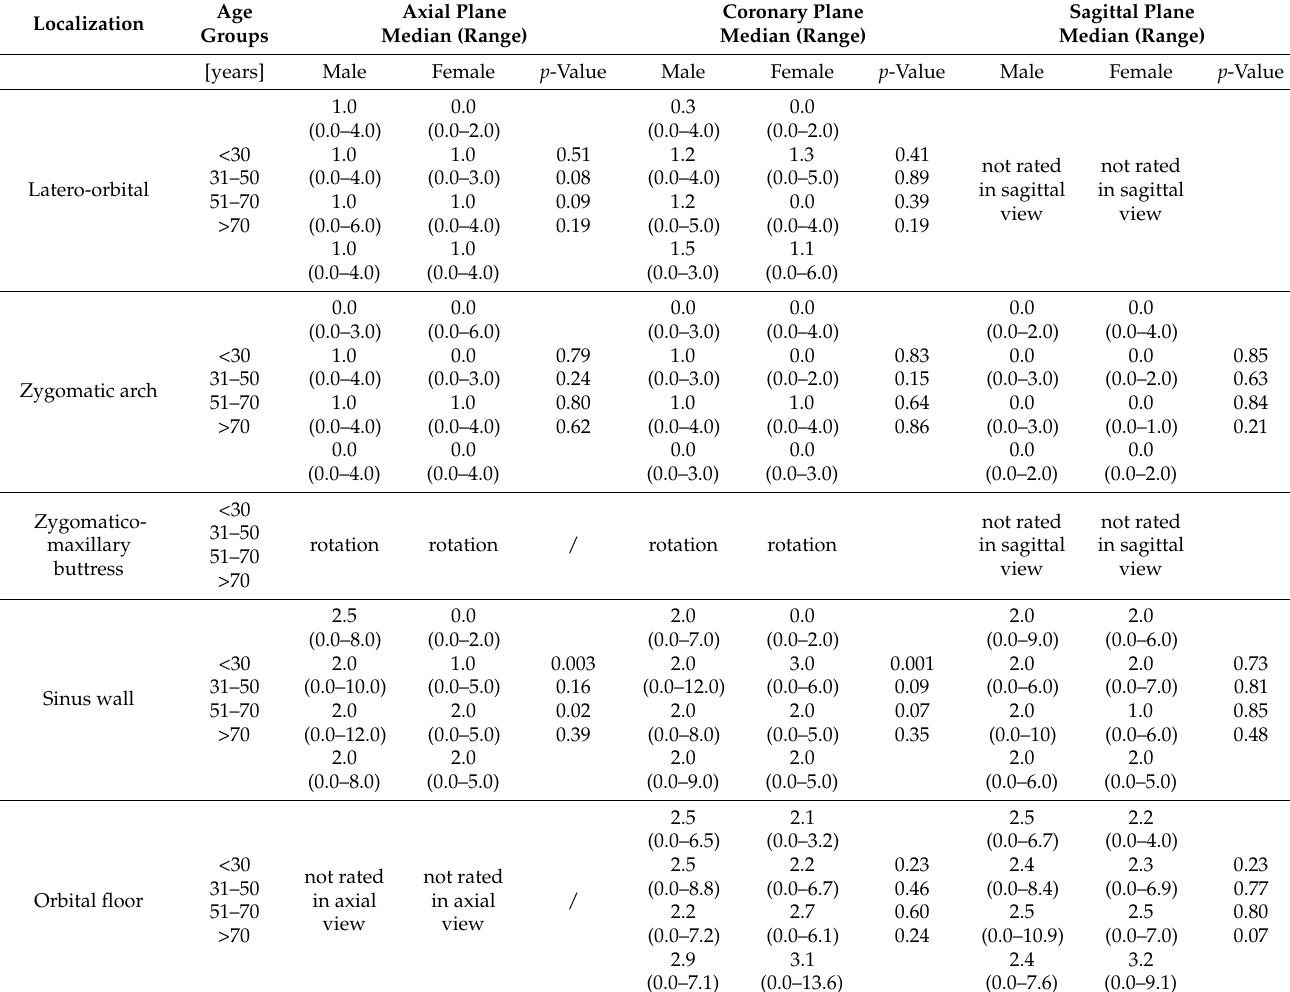
Table 7. Radiological findings and extent of bony dislocation [mm] and incidence of peribulbar herniation [mm] in isolated unilateral zygomatico-orbital